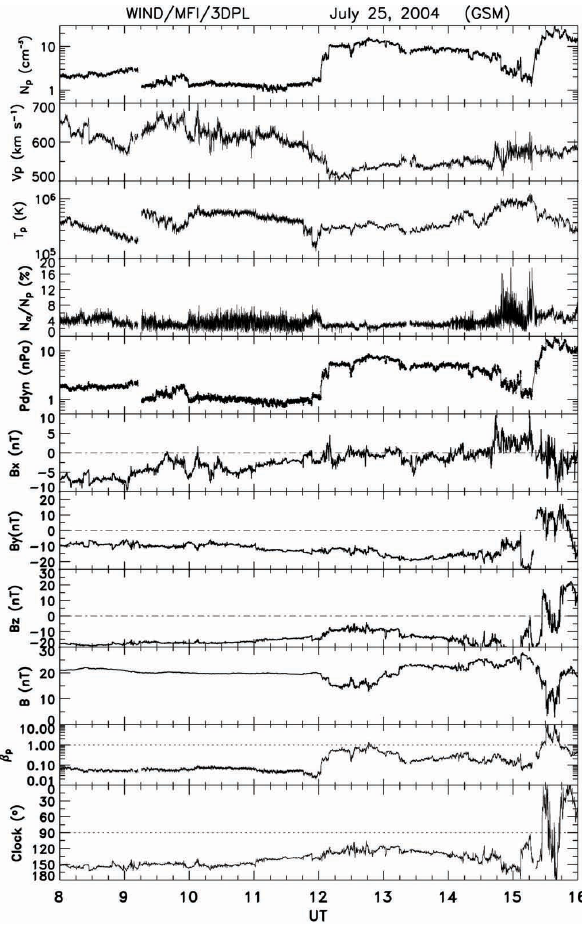
Fig. 6. Interplanetary plasma and field data obtained from space- craft Wind during the interval 08:00–16:00UT on 25 July 2004. Same format as in Fig.